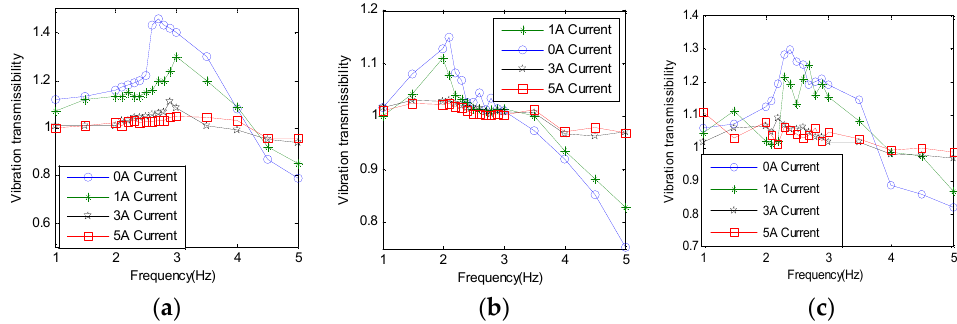
Figure 18. Test results of the multi-dimensional damping seat platform. ( a ) Vertical direction test results; ( b ) horizontal direction test results; ( c ) roll direction test results.